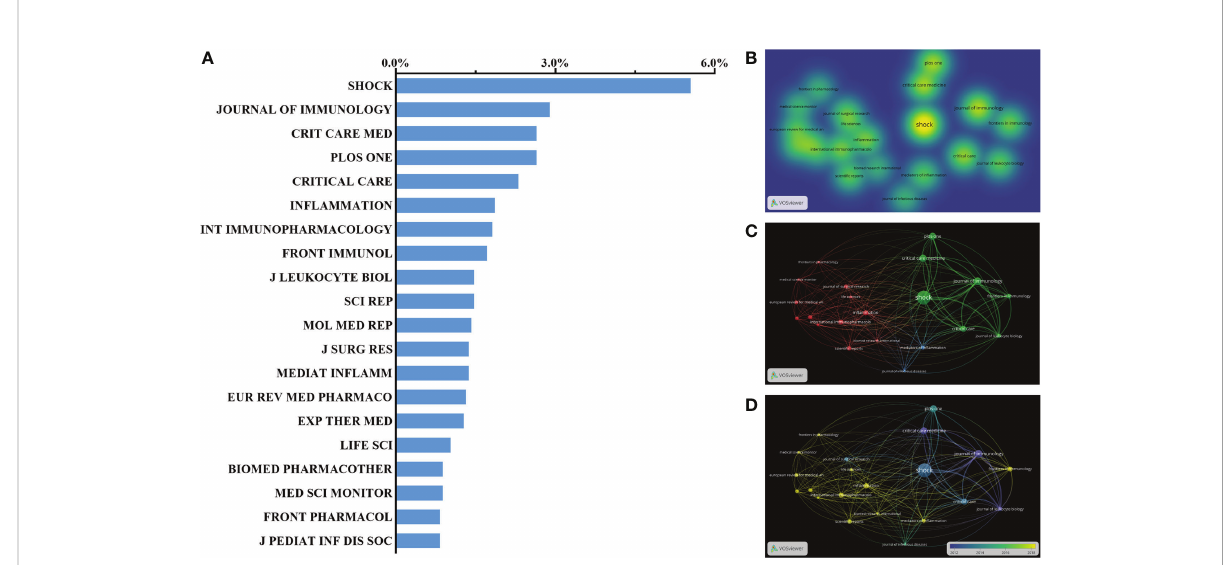
FIGURE 5 Distribution of published journals with respect to sepsis and programmed cell death. (A, B) Distribution of top 20 journals publishing research on sepsis and programmed cell death. (C) The network and relation between the top 20 journals. (D) Distribution of published journals is shown according to the average time. The blue color represents the early years, and the yellow color represents recent